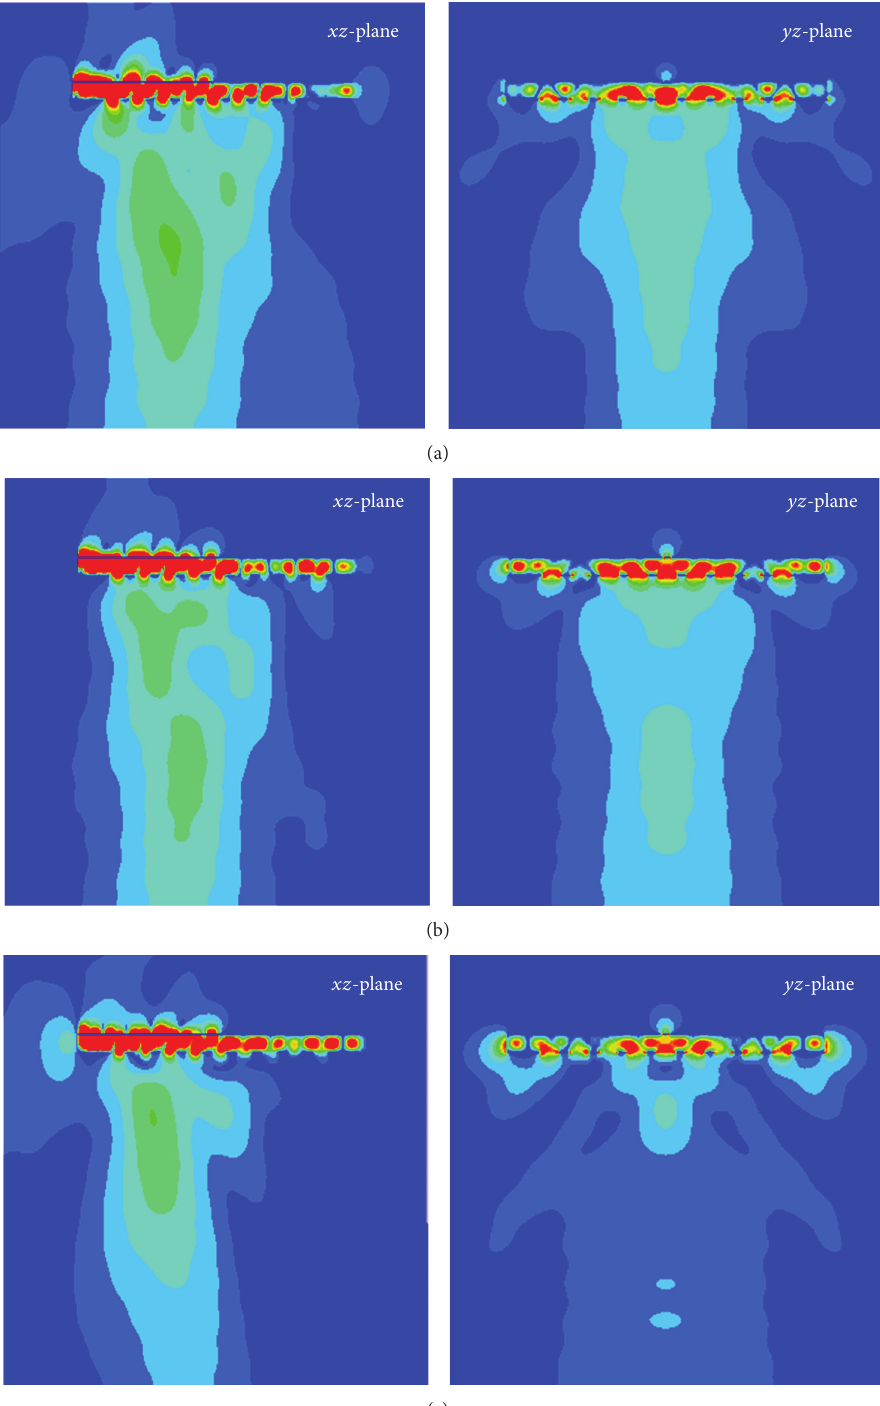
Figure 9: Simulated E-field distribution along the CPW ( 𝑥𝑧 -plane) and leaky-wave slit ( 𝑦𝑧 -plane) at different frequencies of the antenna: (a) 21.5 GHz, (b) 21.7 GHz, and (c) 21.9